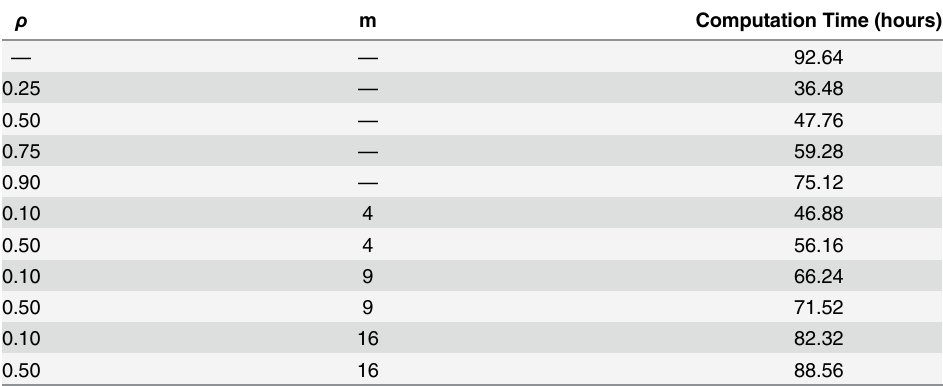
Table 1. Average computation time for the simulation